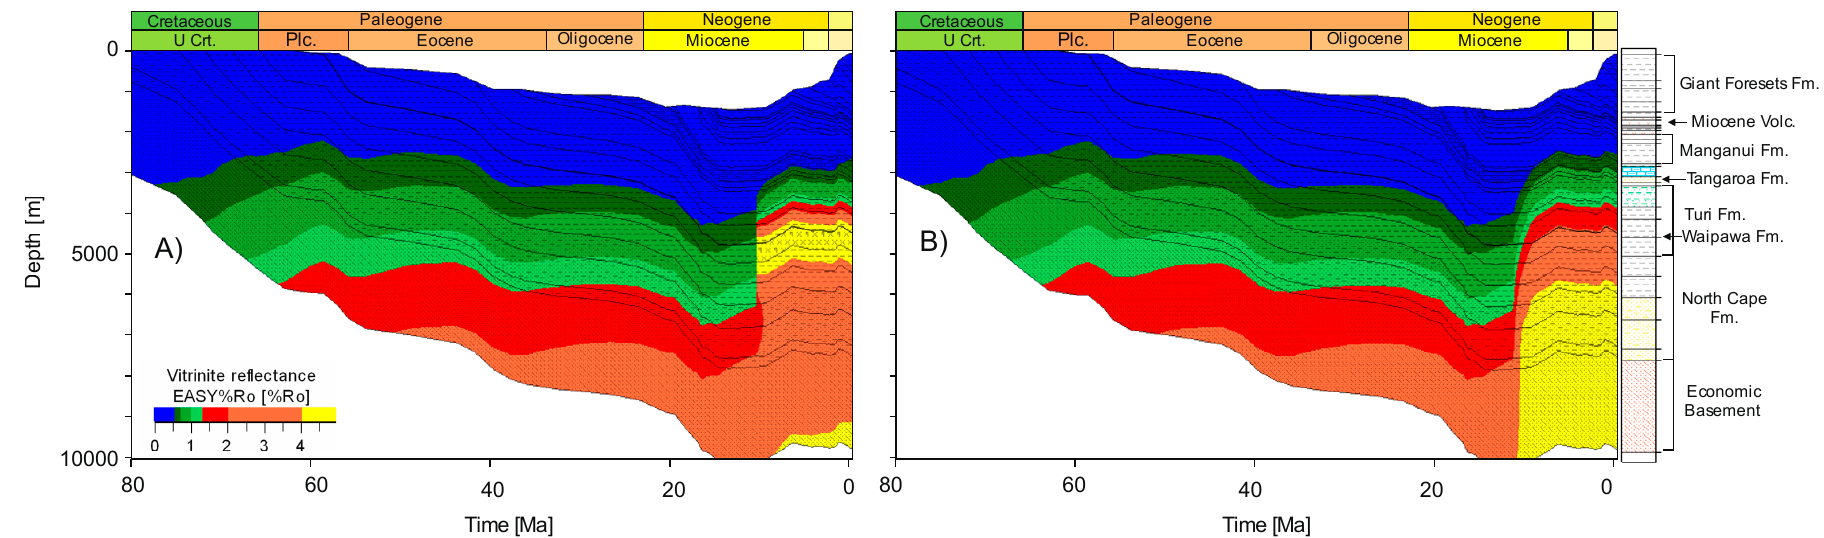
Figure 13. Maturity overlay on the burial history for Kora-4. The model shows thermally immature rocks in blue and over-mature rocks in yellow. The oil and gas windows are green and red, respectively. ( A ) magmatic emplacement in sediments at 11 Ma; ( B ) magmatic intrusion in the basement at 11 Ma.